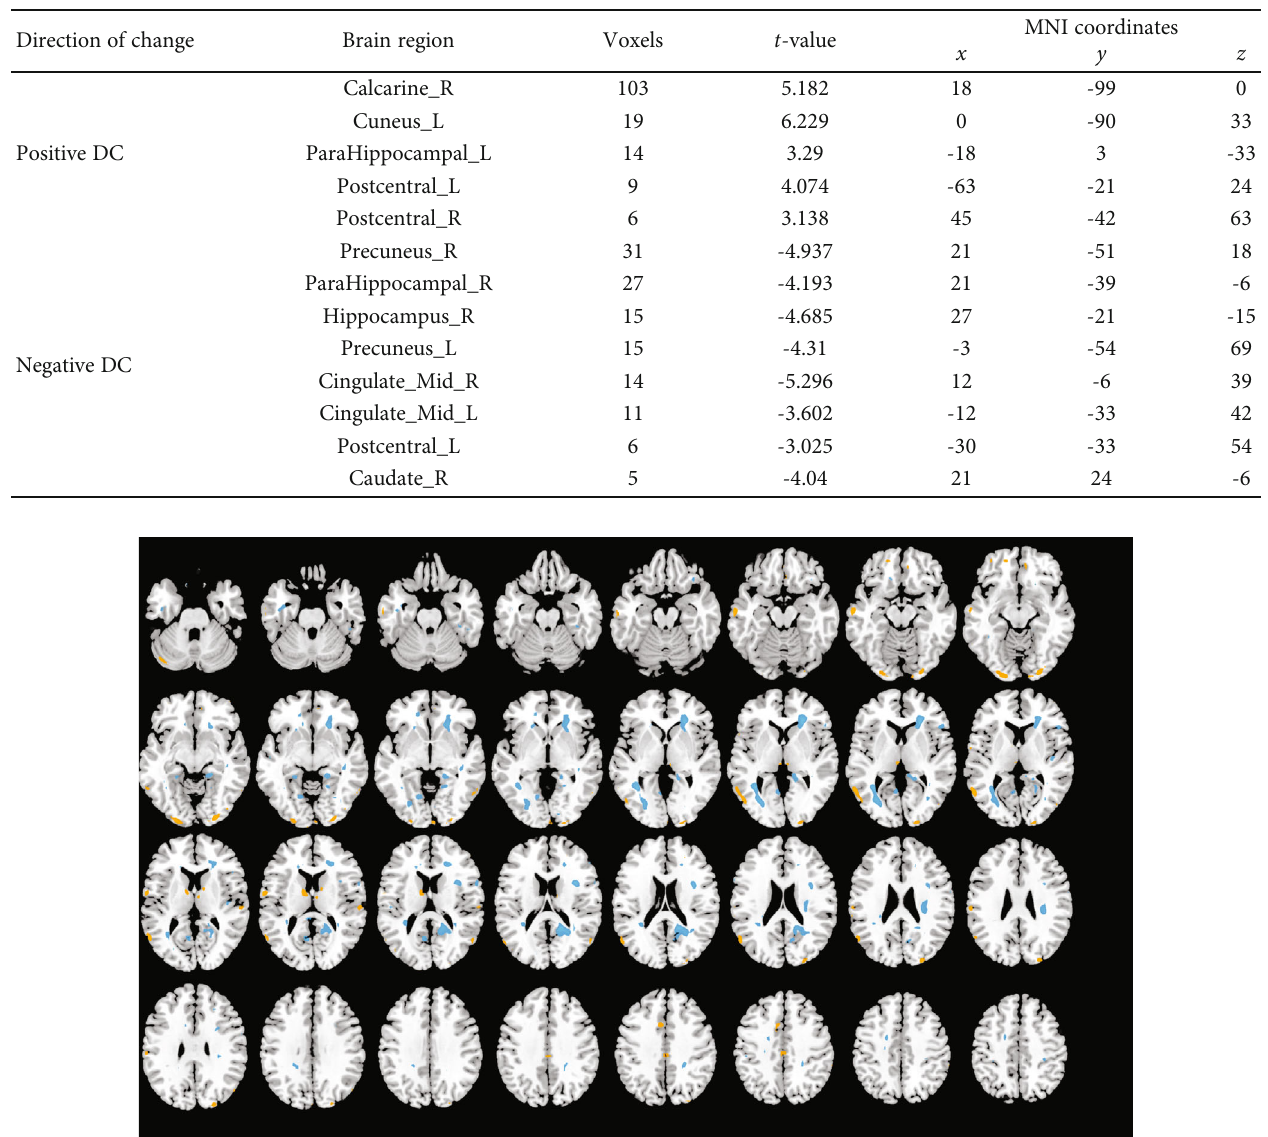
Table 6: Relative regional changes in DC at 6 months.